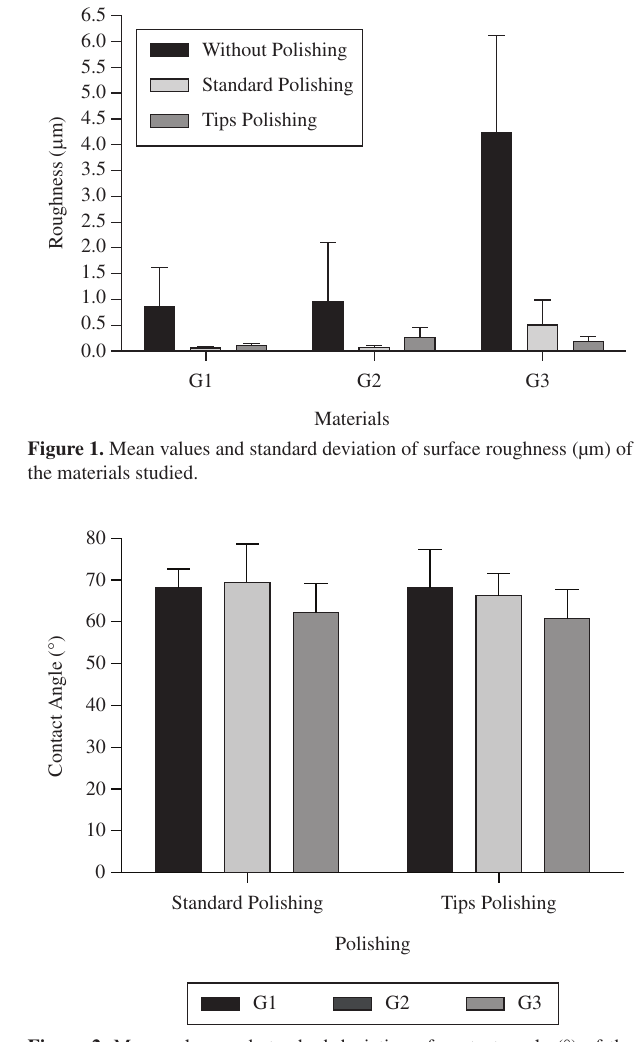
Figure 2. Mean values and standard deviation of contact angle (°) of the materials studied. Table 1. Mean values and standard deviation of surface roughness of groups ( µ m), according to the surface treatment.